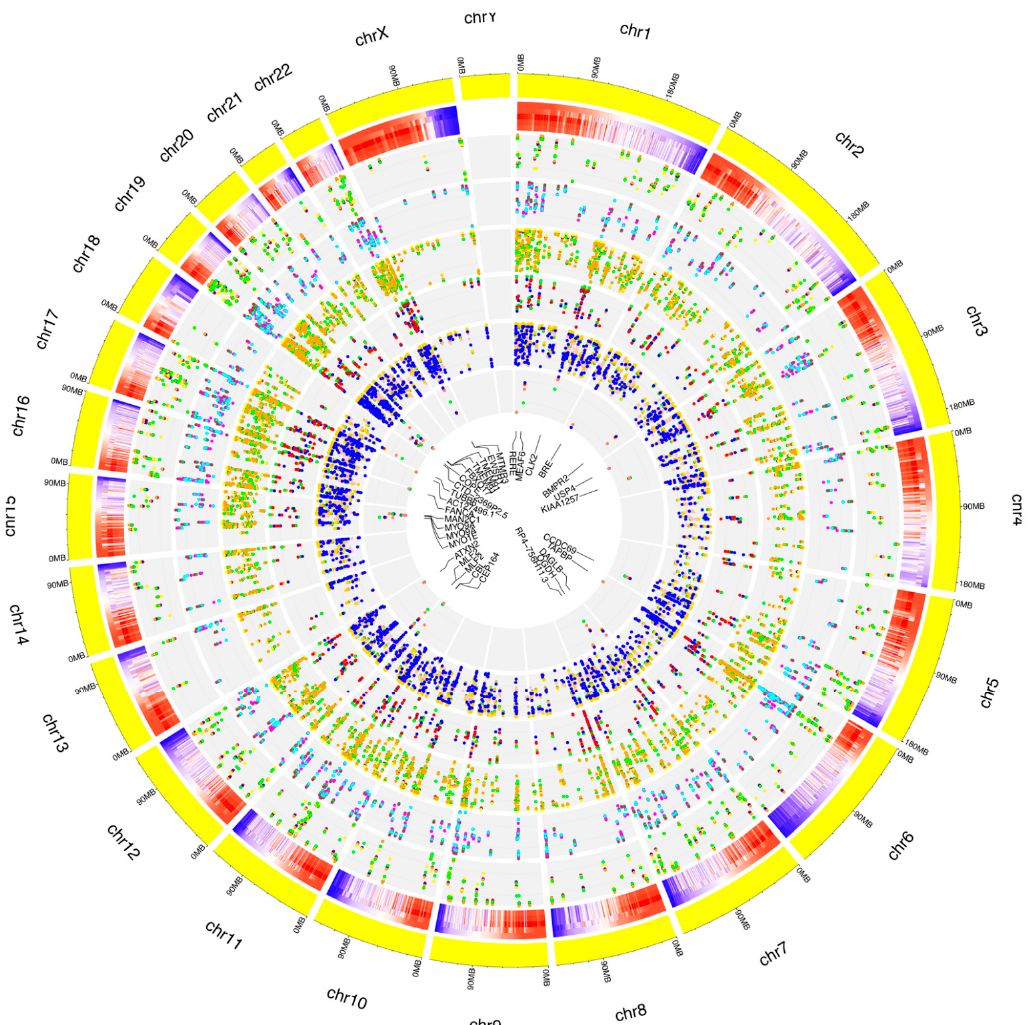
Figure 5. Distribution of known RNA editing sites from RPE cells across human chromosomes. The human genome is shown as a circle. For each chromosome, the position of the editing sites along with their average editing ratio (heatmap) is shown for different time points. From outside to inside: (1) N° of A-to-I only editing sites common to all considered time points and controls. The red, blue, orange, yellow and green dots indicate CTRL, 1 h, 2 h, 3 h and 6 h time points, respectively. (2) N° of C-to-U only editing sites common to all considered time points and controls. The purple, green, maroon, magenta and cyan dots indicate CTRL, 1 h, 2 h, 3 h and 6 h time points, respectively. (3) N° of editing sites within other-than-CDS and UTRs common to all considered time points and controls. The coral, navy, yellow, green and orange dots indicate CTRL, 1 h, 2 h, 3 h and 6 h time points, respectively. (4) N° of editing sites within CDS common to all considered time points and controls. The yellow, salmon, green, blue and red dots indicate CTRL, 1 h, 2 h, 3 h and 6 h time points, re- spectively. (5) N° of editing sites within UTRs common to all considered time points and controls. The green, orange, gold, pink and blue dots indicate CTRL, 1 h, 2 h, 3 h and 6 h time points, respec- tively. (6) N° of editing sites within repetitive elements common to all considered time points and